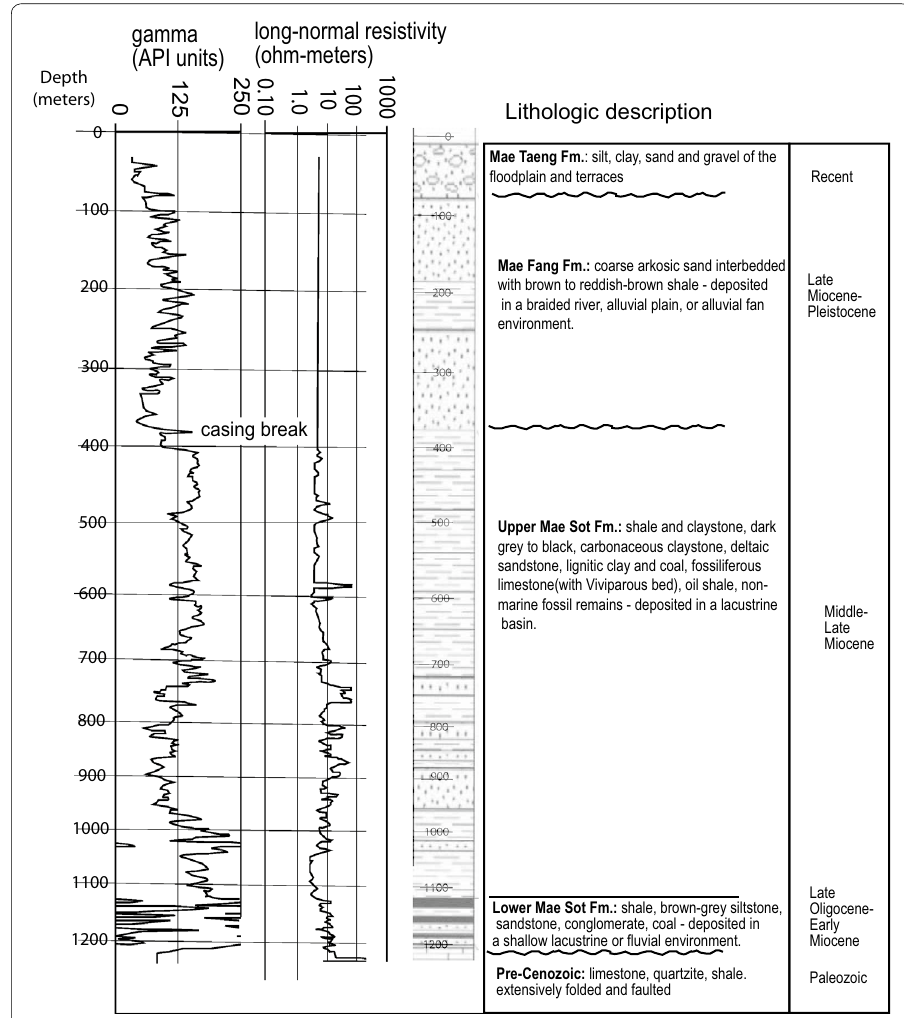
Fig. 7 Geophysical logs and stratigraphy of the Cenozoic basin sediment in well FA-HM-50-03 in the south- ern Fang basin (location shown in Figs. 2, 3) (after Giao et al. 2011). Resistivity log shows the low resistivity (~ 6 Ωm) of the upper 300 m of the clayey Mae Sot